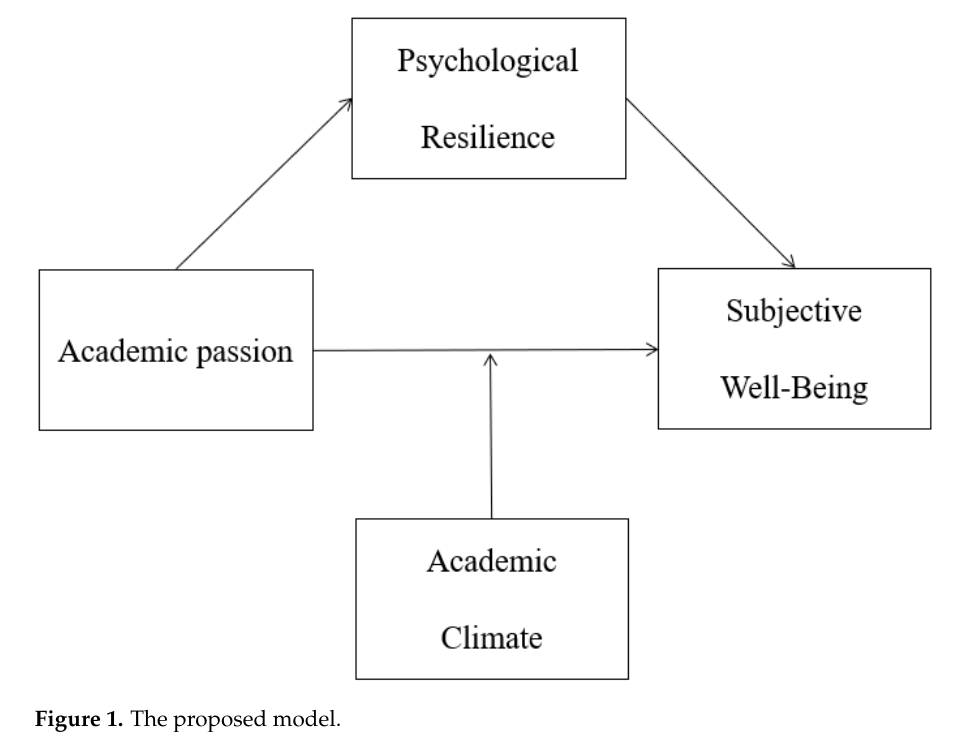
Figure 1. The proposed model.